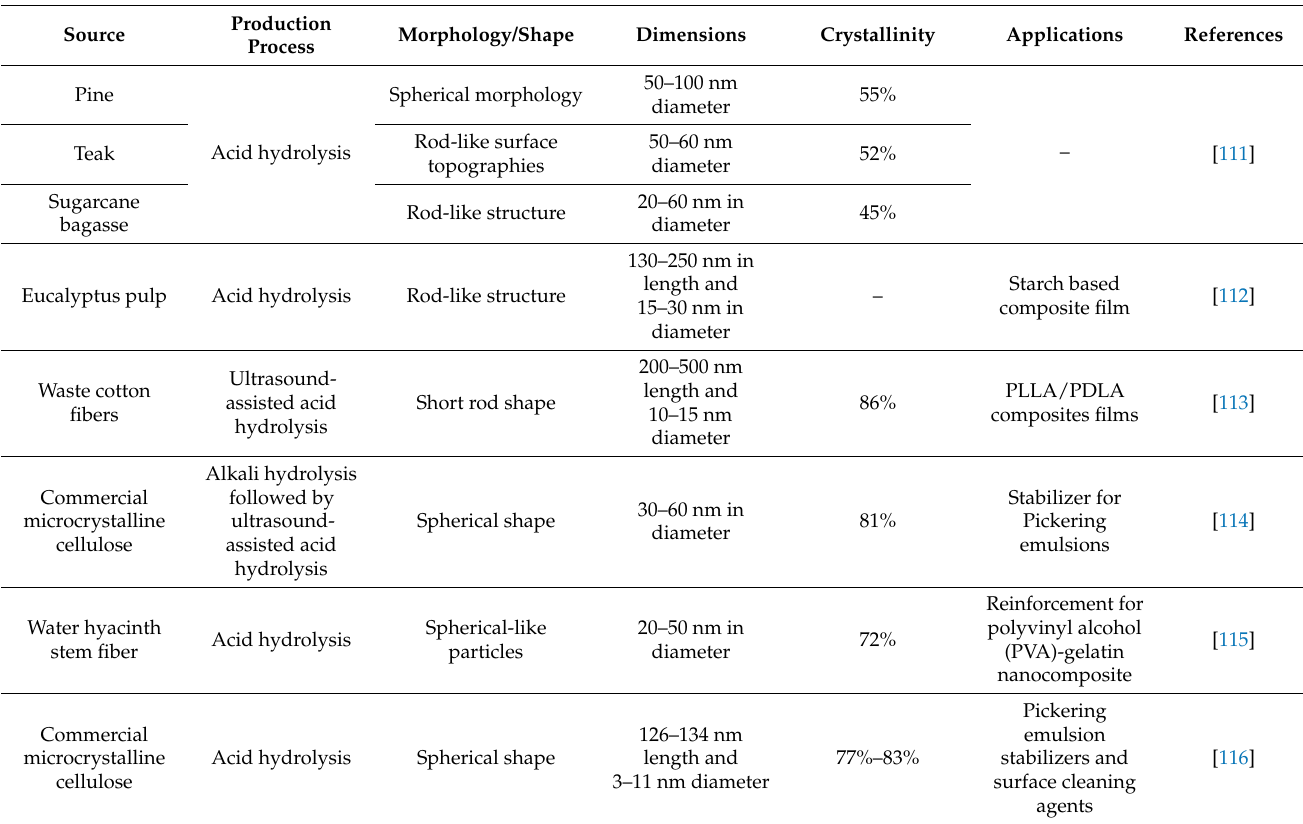
Table 3. Recent advances in the production process, physicochemical characteristics and application of CNC extracted from different sources (literature data for years 2020 and